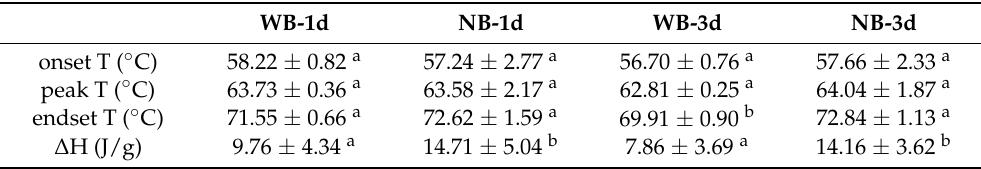
Figure 4. Intramuscular connective tissue (IMCT) residues after extraction and filtration in wooden breast (WB) and normal breast (NB) muscles of broilers at day 1 and day 3 postmortem. Means without a common superscript differ, p < 0.05. Table 1. Thermal properties of intramuscular connective tissue from wooden breast (WB) and normal breast (NB) muscles at day 1 and day 3 postmortem shown as onset, peak and endset denaturation temperatures, and the denaturation enthalpy (ΔH).